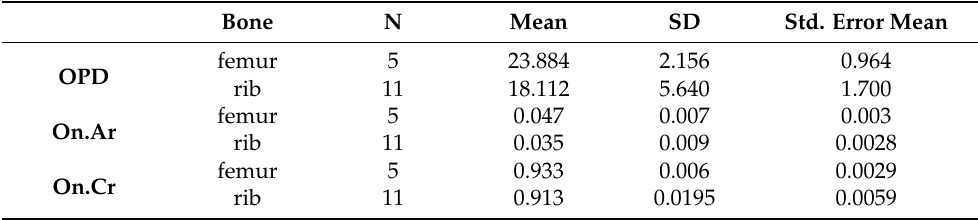
Table 11. Blackburn sample descriptive statistics for the histomorphometric variables depending on the skeletal